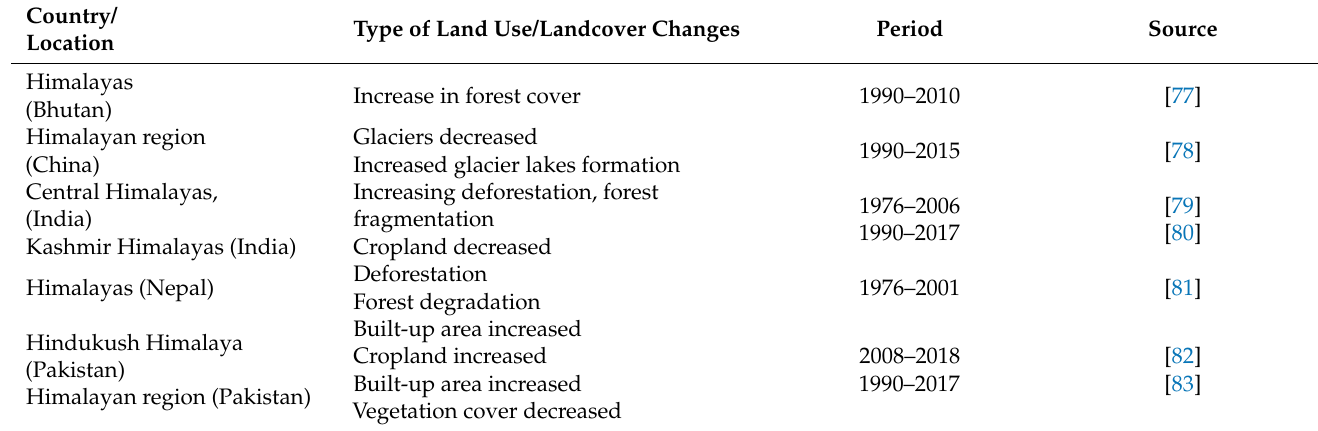
Table 3. Land use/land cover changes in the Himalayan